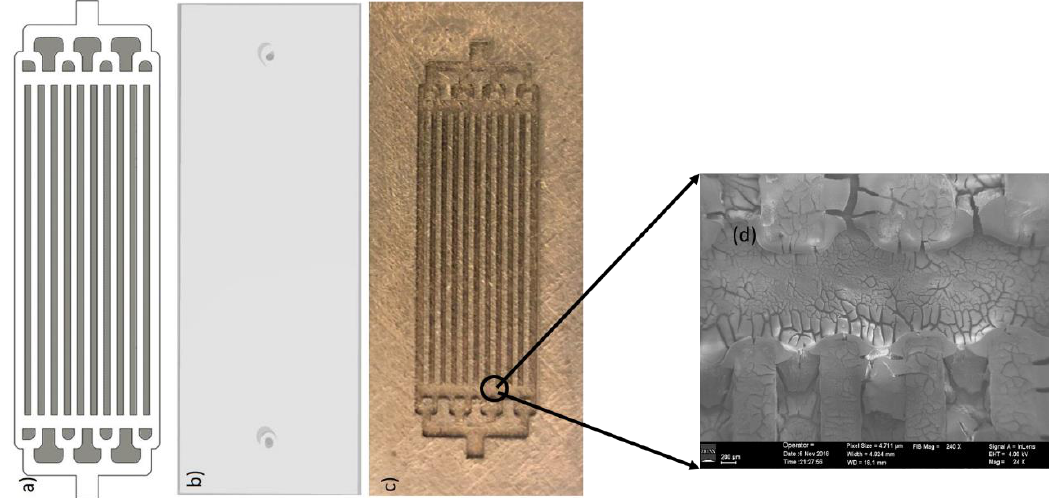
Figure 13. ( a ) and ( b ): AutoCAD design of the microreactor and cover channel ( c ) 3D printed reactor, ( d ) SEM image of the microchannels coated with catalyst prior to FT studies.